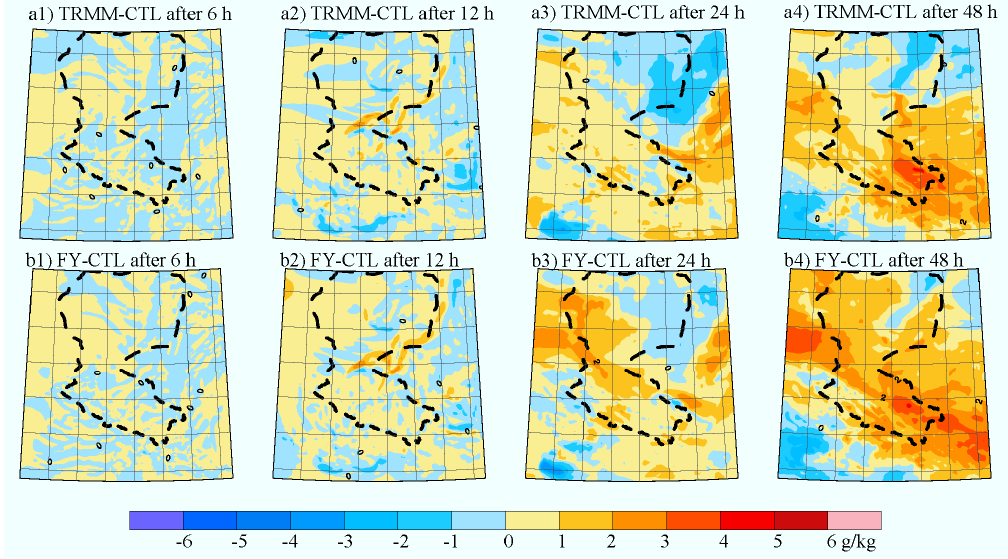
Figure 7. Spatial distribution of water vapor mixing ratio (g/kg) forecasting difference in the ninth model layer at 6 h, 12 h, 24 h, and 48 h: (a1–a4) for TRMM assimilation minus control simulation; (b1–b4) for FY assimilation minus control simulation.